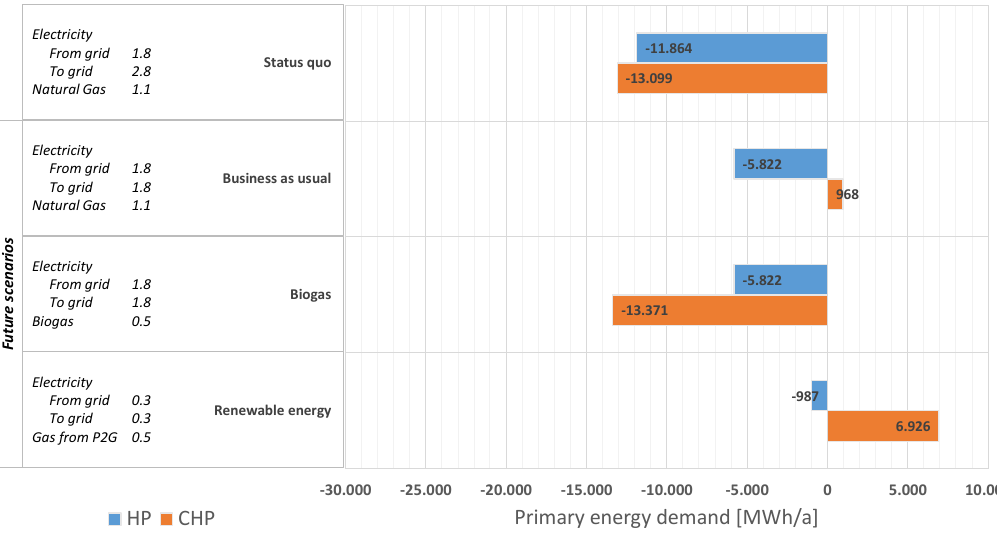
Figure 15. Comparison of different PEFs to assess the HP and CHP